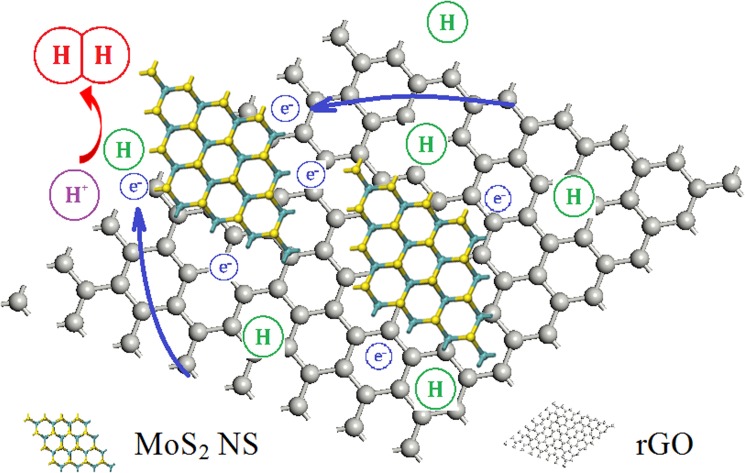
Schematic illustration of the mechanism governing the catalytic HER on the MoS2 NSs/rGO structure.